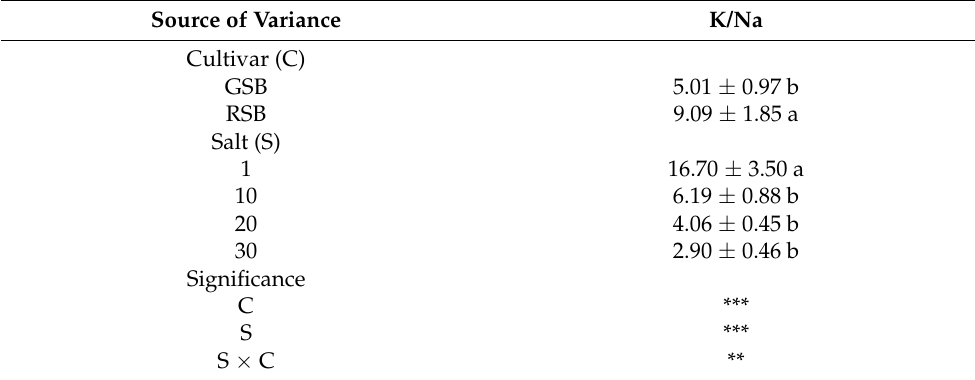
Table 3. Main effect of the cultivar (C), salt concentration (S; in mM NaCl), and their interaction on the K/Na. The significance of the factors and their interactions was evaluated with a two-way ANOVA (ns: not significant; **: p < 0.01; ***: p < 0.001), using Duncan’s multiple range test as post-hoc test for mean separation among conditions. Different letters indicate, for each variable, different homogenous groups according to Duncan’s test for S, or the Student’s t -test for C. GSB: ‘Green Salad Bowl’; RSB: ‘Red Salad Bowl’. Salt concentration is in mM